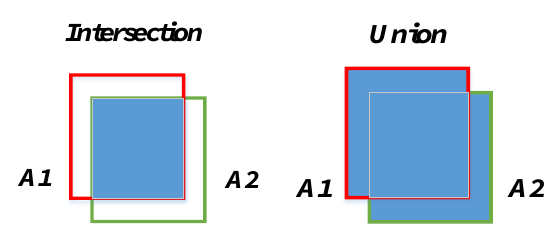
Figure 6. The schematic diagram of IOU.